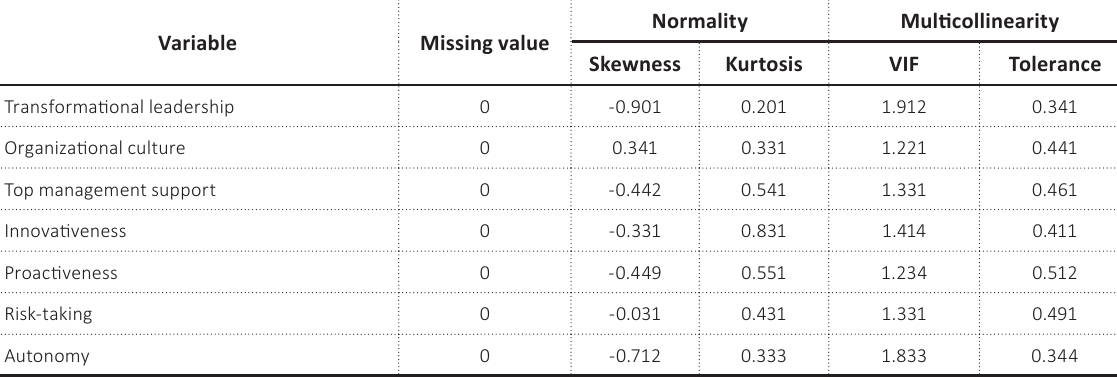
Table 1. Normality and multicollinearity tests